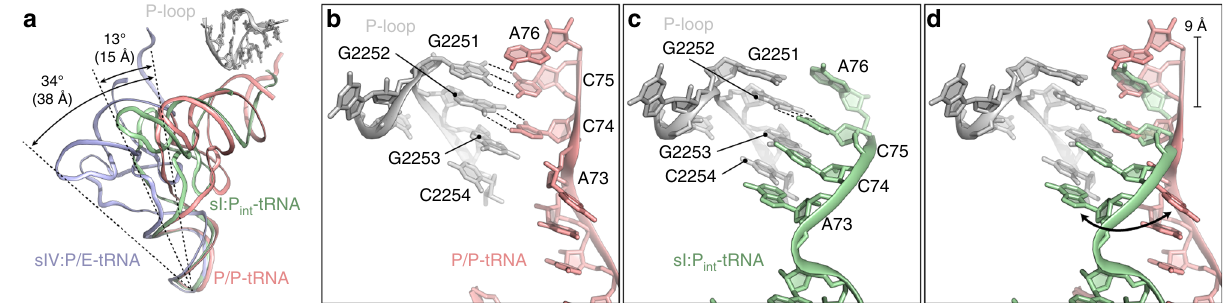
Fig. 3 Small subunit rotation induces P-site tRNA rotation. a Comparison of the relative position of a classical P/P-tRNA (salmon) from the RF1-API-70S complex 26 to P int tRNA (green) conformation observed in state I and the hybrid P/E-site tRNA observed in state IV (slate), with the degree of rotation and distance shifted indicated. The P-loop of the 23S rRNA is shown for reference. b The P/P-site tRNA (salmon) in the RF1-API-70S complex 26 and c the P int - tRNA (green) in state I interact with nucleotides within the P-loop (H80) of the 23S rRNA. Potential hydrogen bonds are indicated with dashed lines. d Superimposition of b and c with arrow indicating the fl ipped A73